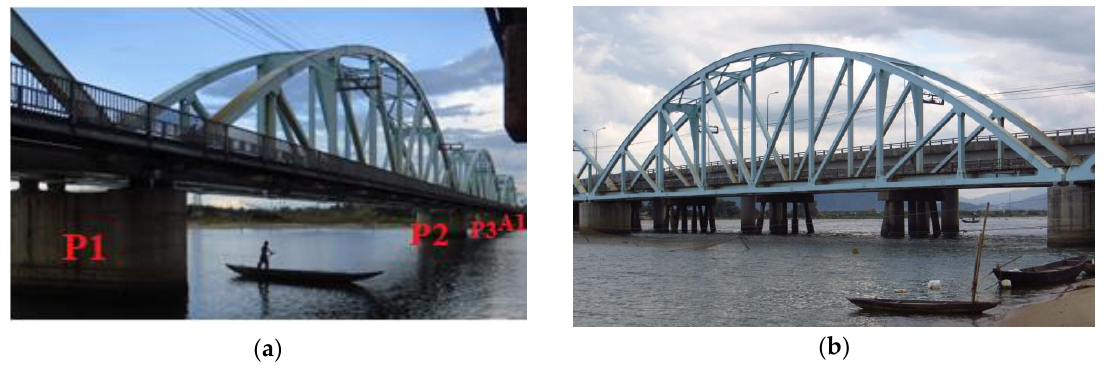
Figure 1. Some views of Nam O Bridge: ( a ) Upstream side; ( b ) Downstream side.